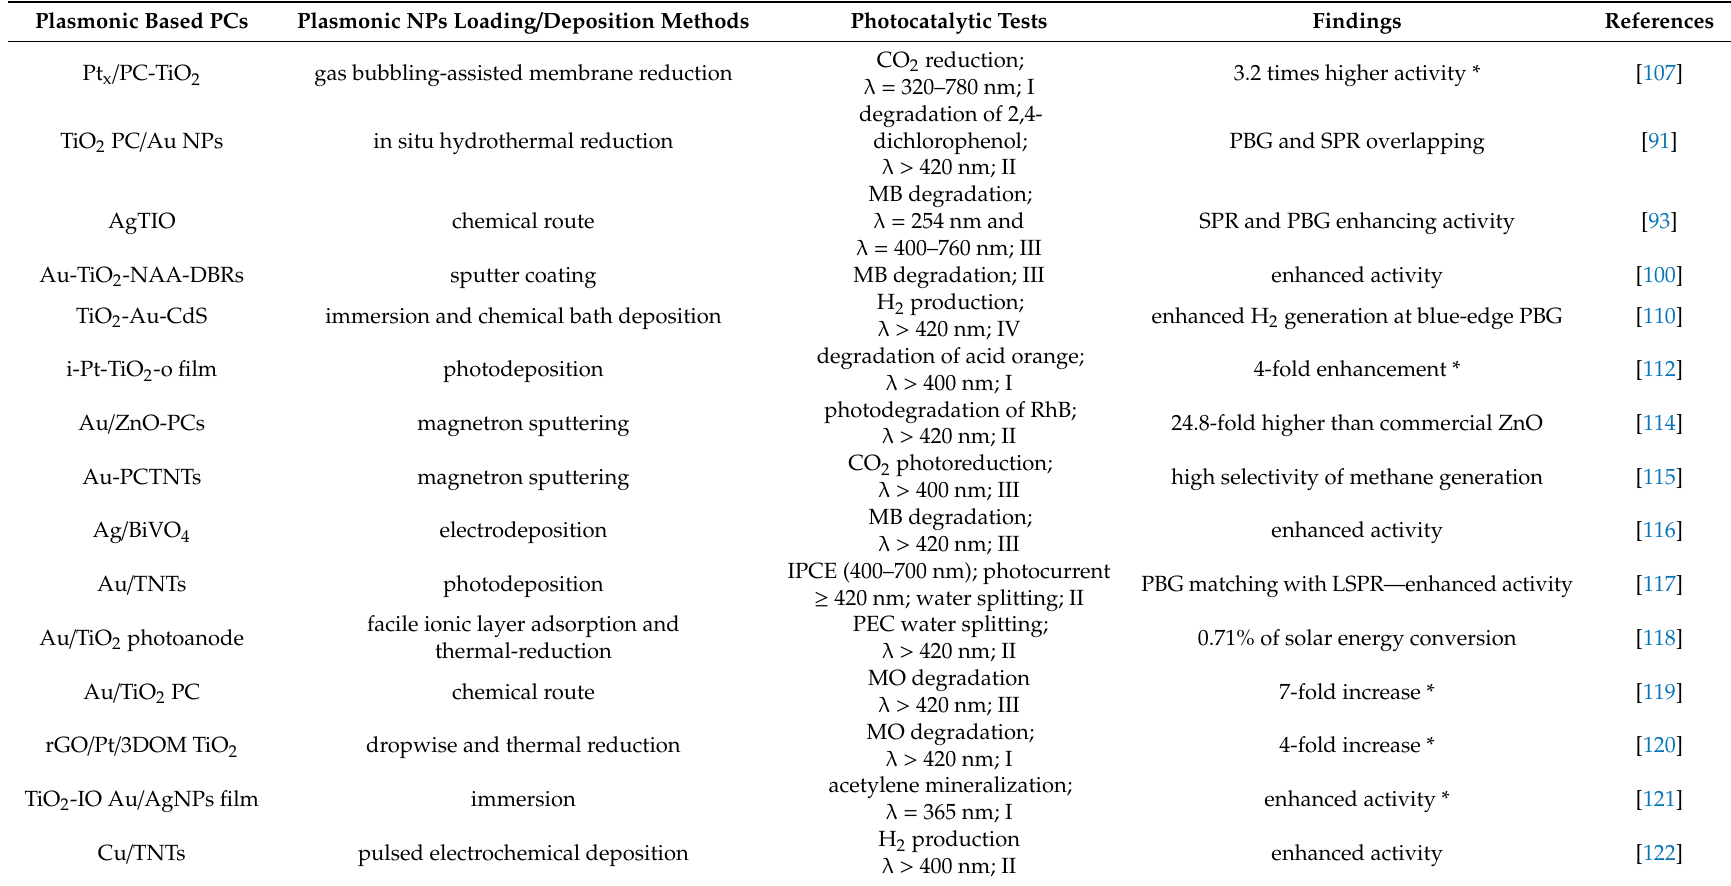
Table 1. Synthesis methods and activity tests for NM-modified